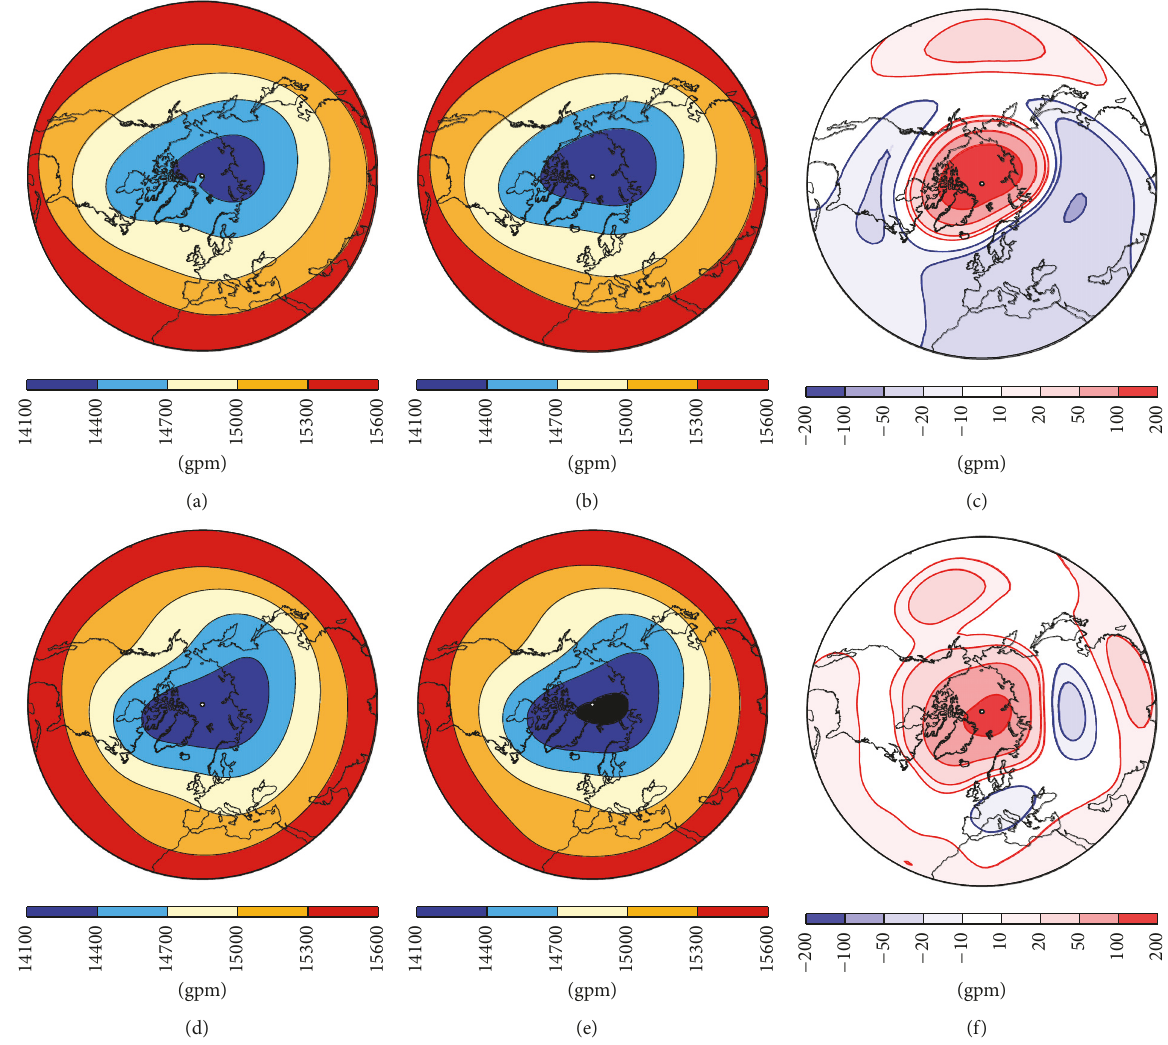
Figure 4: The same as in Figure 3 but for the 167 hPa model level.